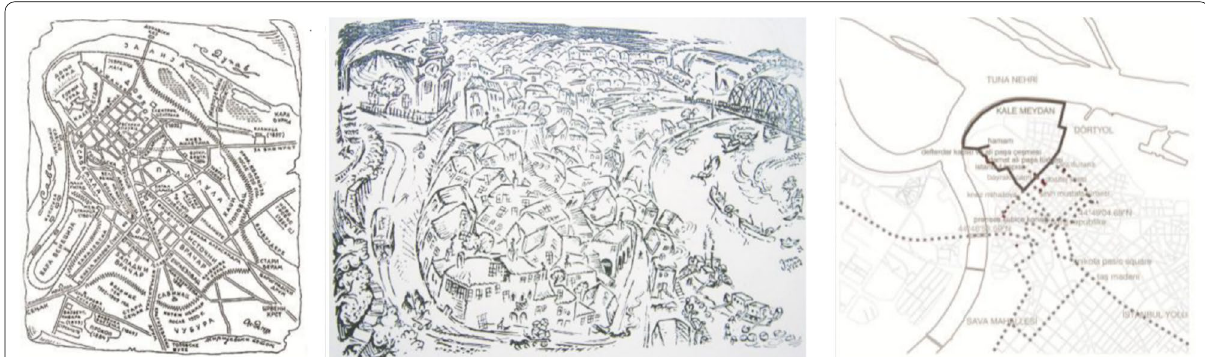
Fig. 6 Experience of the public space network. Case of Stari Grad—inhabitant (left) and visitor (right)